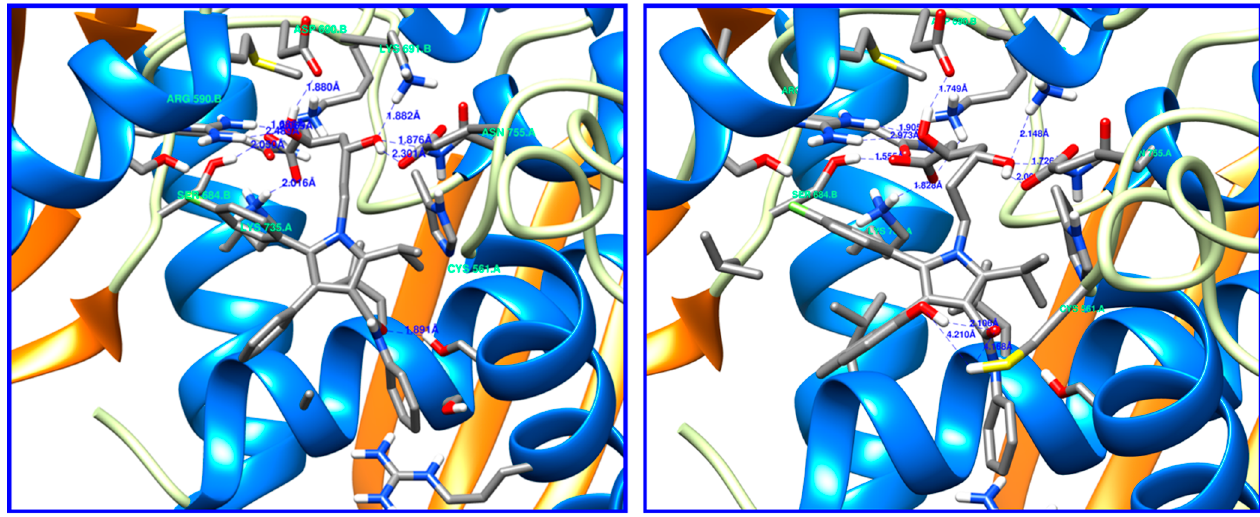
Figure 2. Top-scoring conformation found with AutoDock4. On the ( left ) atorvastatin I , on the ( right ) M -2-hydroxy-naphthyl atropostatin M -IIg .